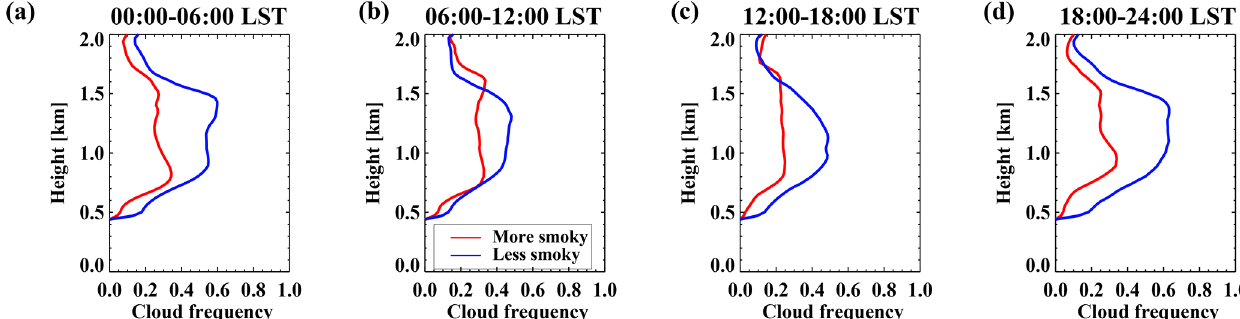
Figure 8. Diurnal cycle in the mean cloud frequencies derived using Ka-band zenith pointing cloud radar (KAZR) reflectivities > 35dBZ at their vertical resolution of 30m, composited by “more” (red) versus “less” (blue) smoky conditions from. From left to right: 00:00–06:00LST, 06:00–12:00LST, 12:00–18:00LST, and 18:00–24:00LST.